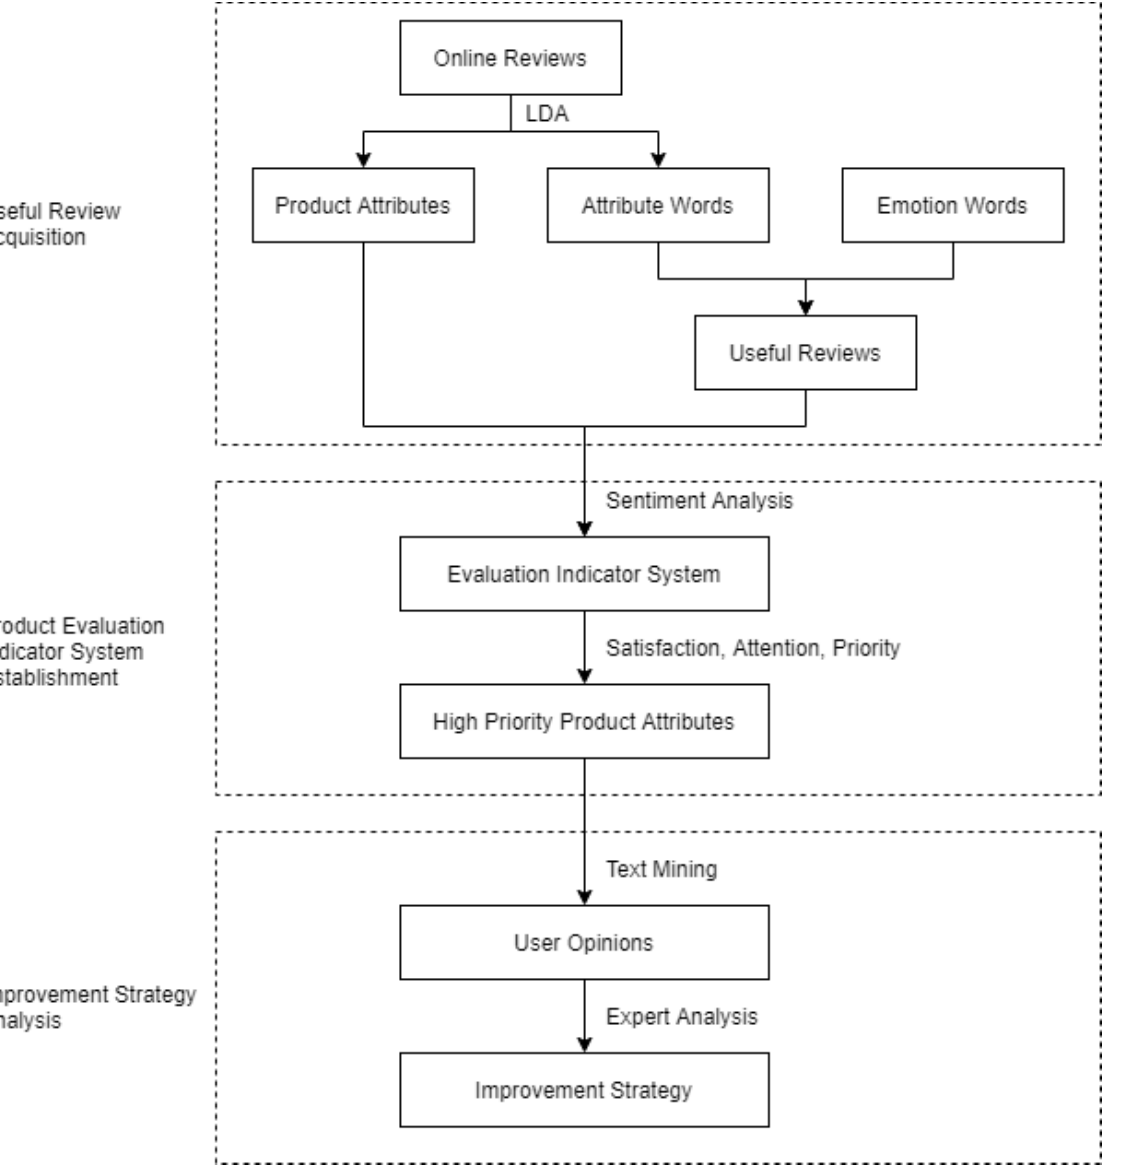
Figure 1. Overall framework of the